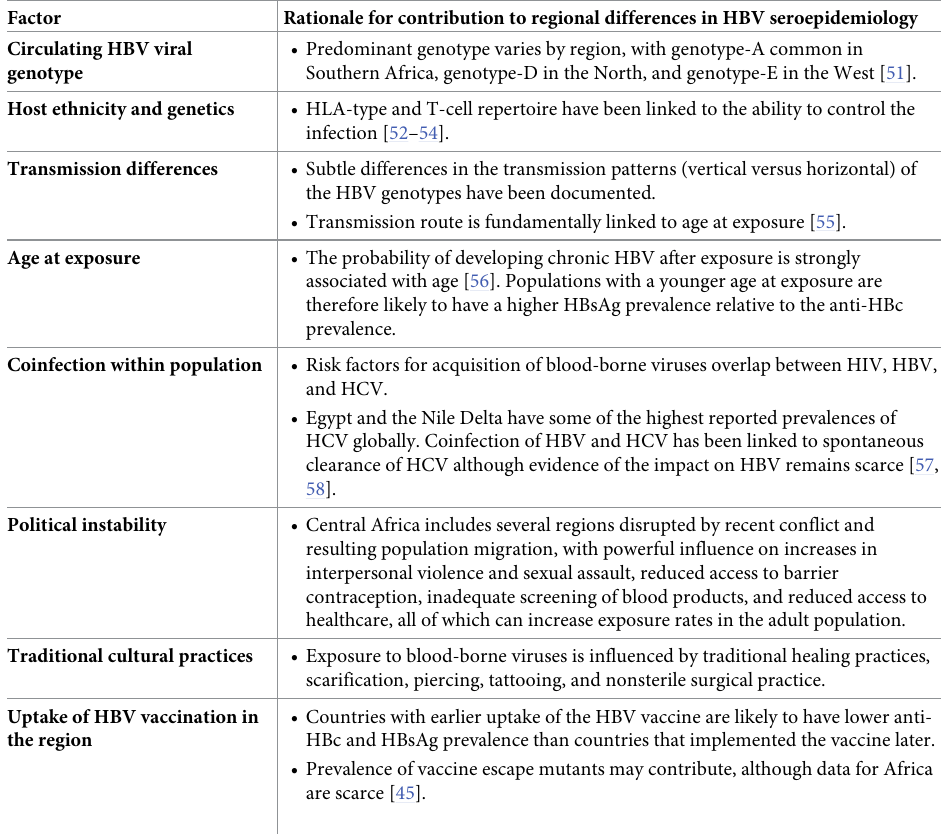
Table 1. Factors that may contribute to regional differences in prevalence of anti-HBc and HBsAg across